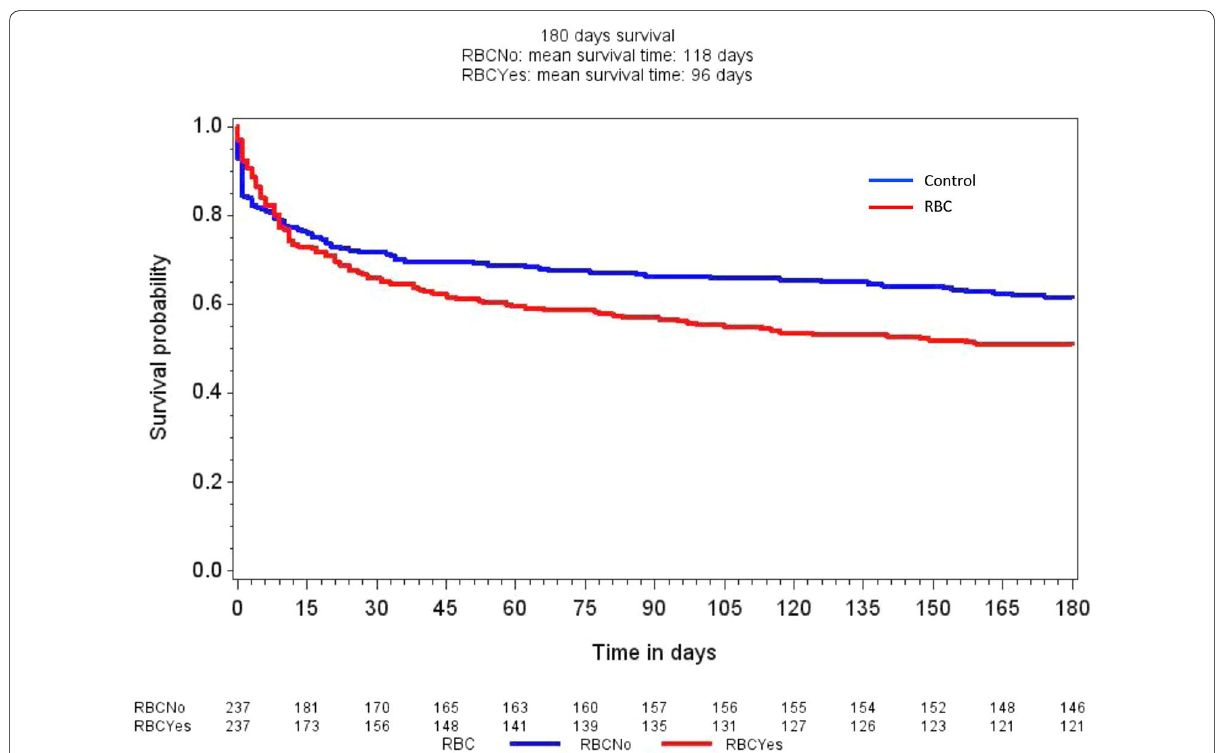
Fig. 4 Kaplan–Meier curves of 180-day survival in the control group (blue line) and the RBC group (red line) ( P RBC group with patients who received red blood cell transfusion any of the first 5 =